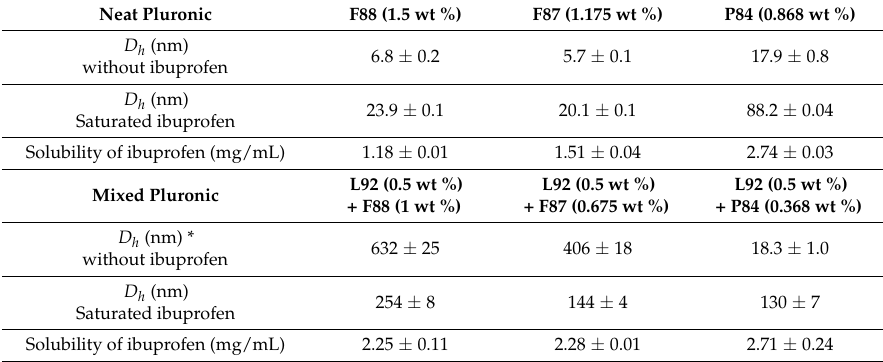
Table 3. Hydrodynamic Diameter of aggregates ( D h , nm) and solubility of ibuprofen in neat Pluronic F8x and binary mixed Pluronic L92 + F8x systems at the same total mass concentration at 37 ◦